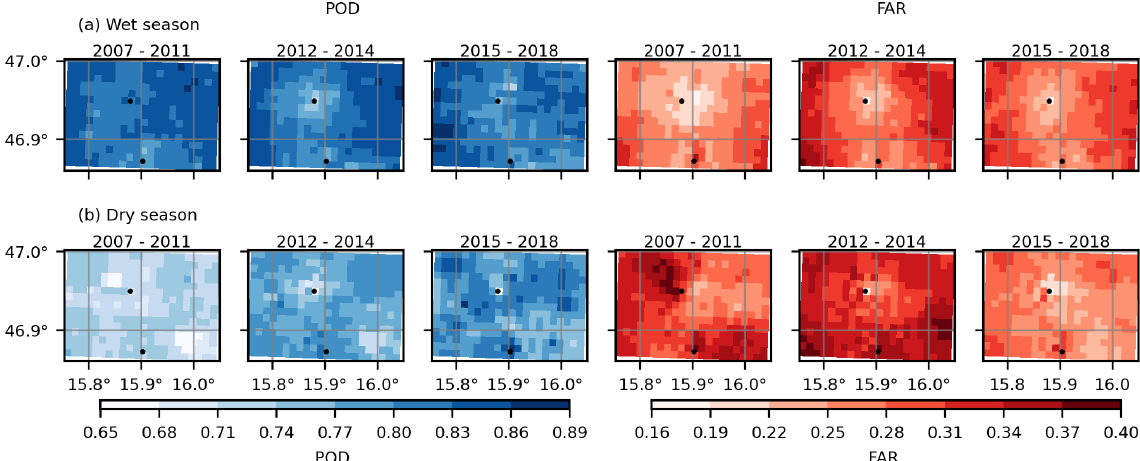
Figure 6. POD and FAR for 15min data based on the 0.1mm threshold for three different periods of time for wet (a) and dry (b) seasons. The black dots indicate the two ZAMG stations.